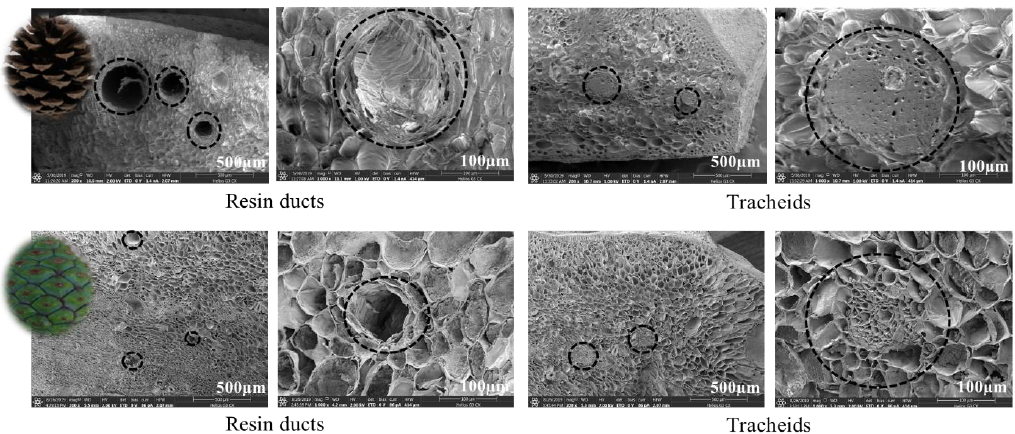
Figure 4. FE-SEM (Field Emission Scanning Electron Microscope) images of internal structure of mature and immature cones.